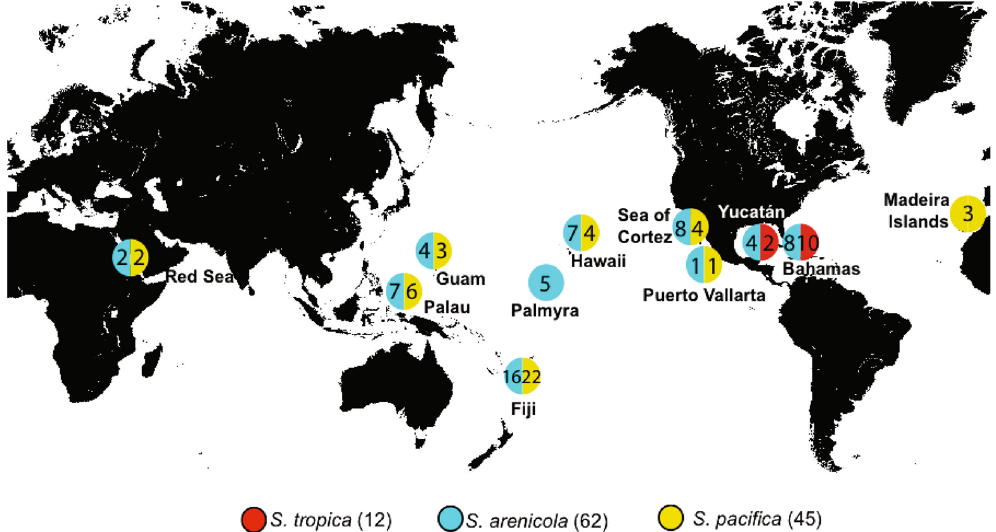
Figure 1. Strain origins. Numbers of strains sequenced at each site for each species with totals in parentheses. Modified with permission from Freel et al . 24 , Environ. Microbiol.